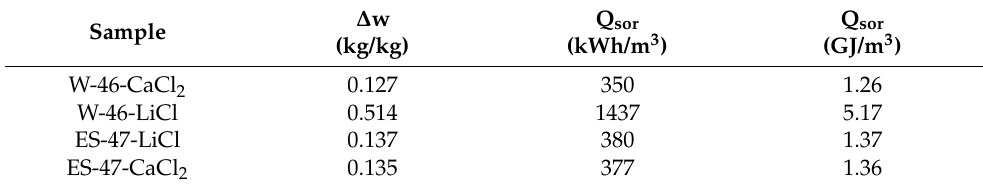
Table 3. Water loading lift and the integral heat of adsorption for the composites.